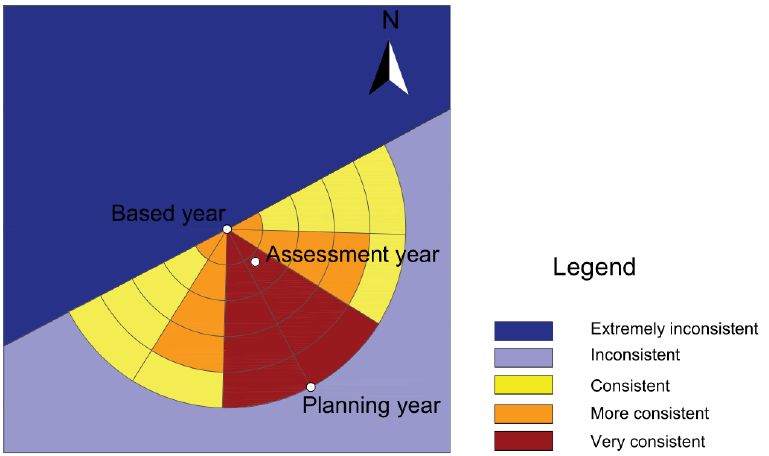
Figure 2. Spatial gravity center transfer of construction land in Rongchang District in